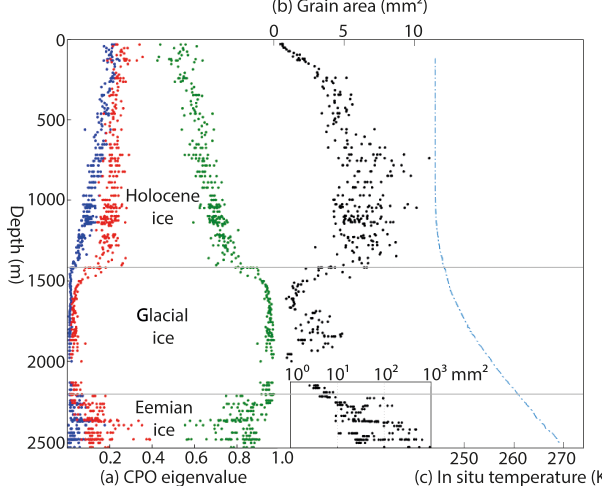
Figure 1. Compilation of microstructure and borehole data of the NEEM ice core: (a) orientation tensor eigenvalue from light mi- croscopy studies (blue, red, green) (Eichler et al., 2013), (b) mean grain area (black dots) (Eichler et al., 2013) and (c) the in situ tem- perature (broken blue line) (Sheldon et al.,